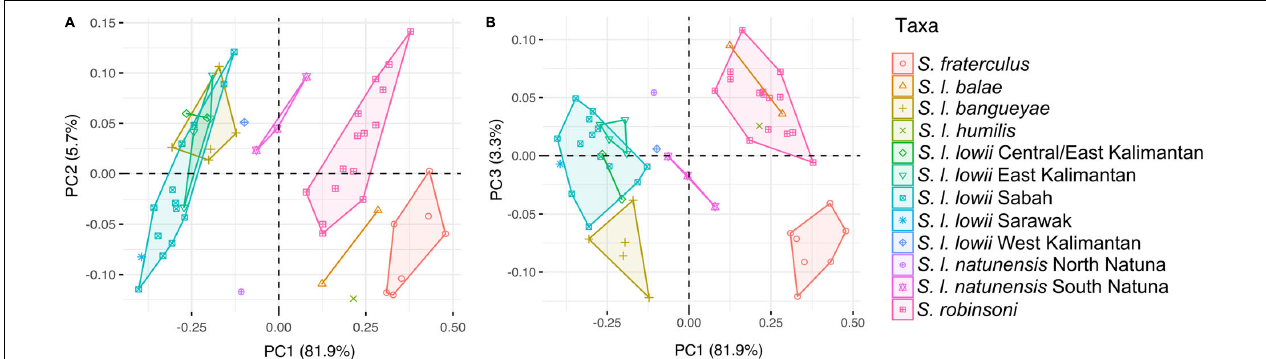
FIGURE 5 | Inter- and intraspecific morphometric variation among species of the Low’s and Fraternal squirrel complex. (A) shows first and second principal components from an analysis of 17 cranial dimensions, while (B) shows first and third principal components of that same analysis. Samples are labeled and colored according to the different subspecies but subspecies with high genetic/phenotypic variation ( S. l. lowii and S. l. natunensis ) have been split into geography-based categories.